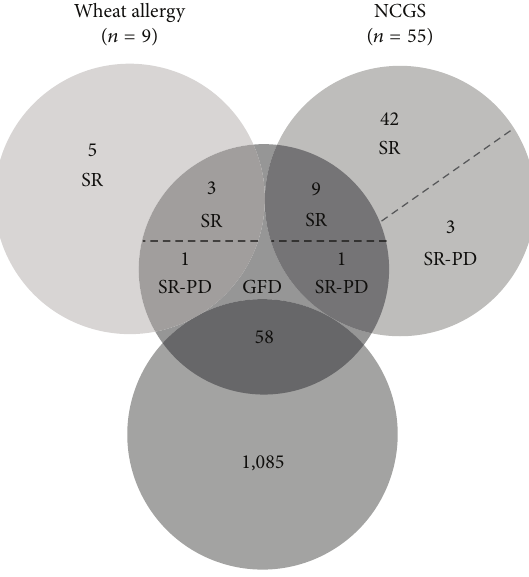
Figure 1: Characteristics of respondents adhering to a GFD. NCGS: nonceliac gluten sensitivity; SR: self-reported wheat allergy or NCGS; SR-PD; self-reported physician-diagnosed wheat allergy or NCGS. General practitioners diagnosed the five SR-PD